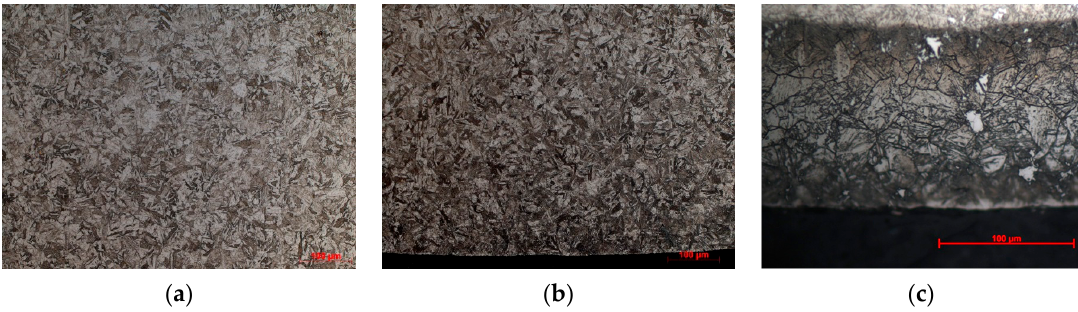
Figure 1. Microstructure of the surface under different treatments ( a ) un-surface treatment specimens; ( b ) shot peened specimens; ( c ) nitrided specimens.